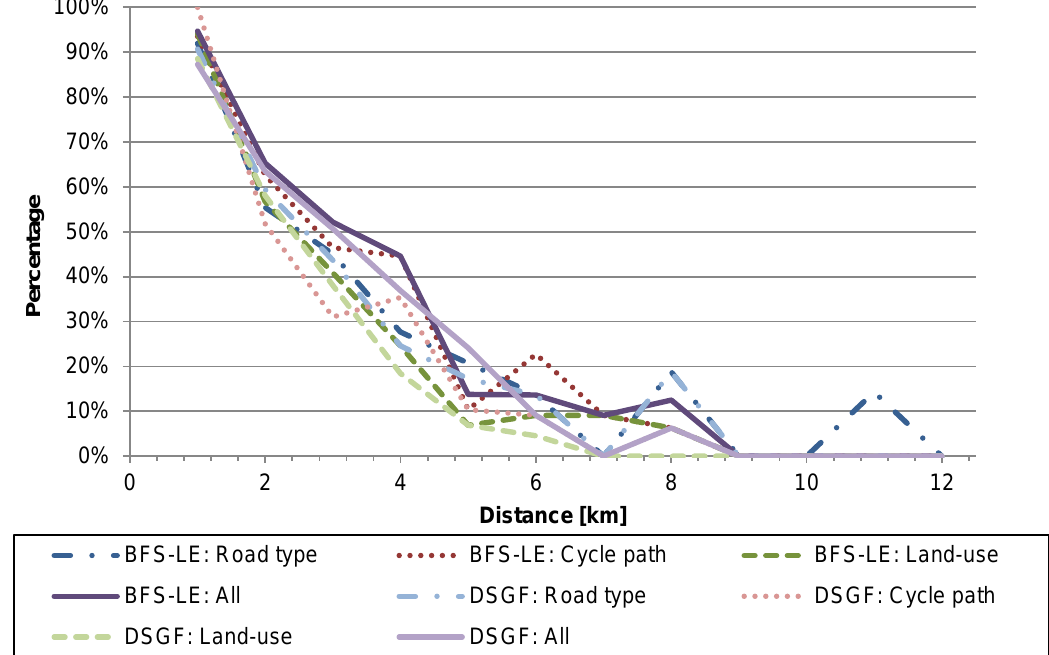
Figure 4. Percentage of chosen route completely replicated as a function of distance.